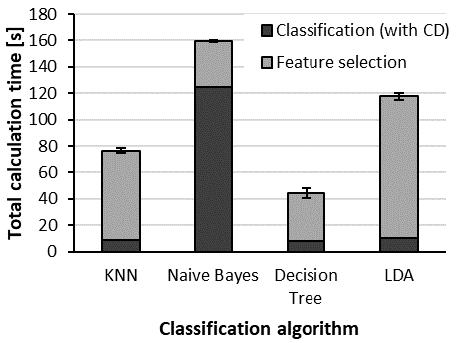
Figure 14. Comparison of classifiers with features chosen by the SFS method.